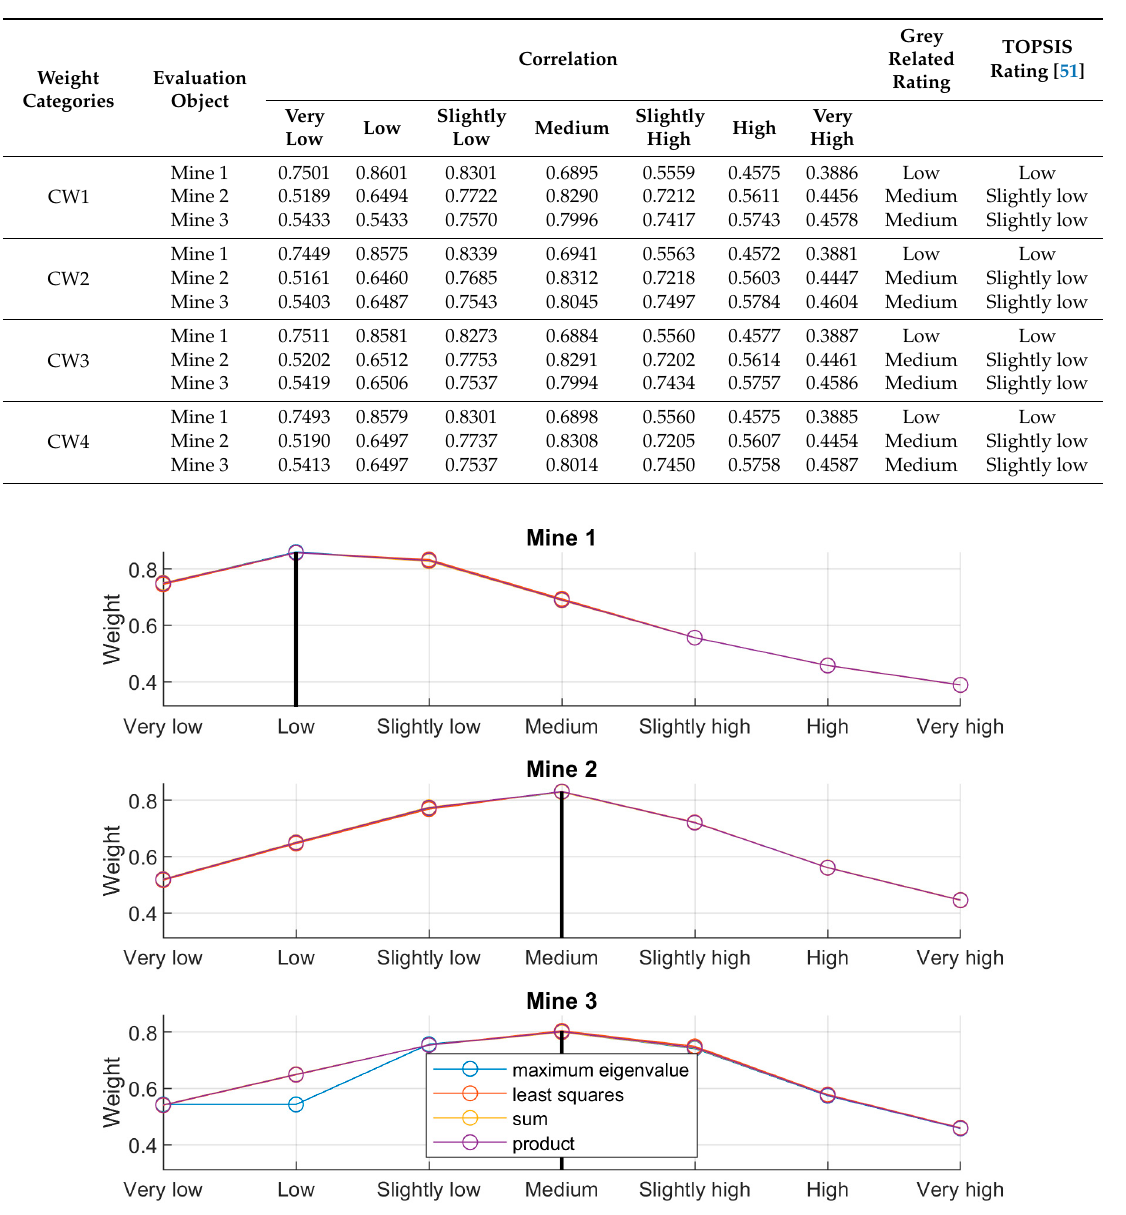
Table 6. Fuzzy-grey correlation risk rating based on rational attitude.